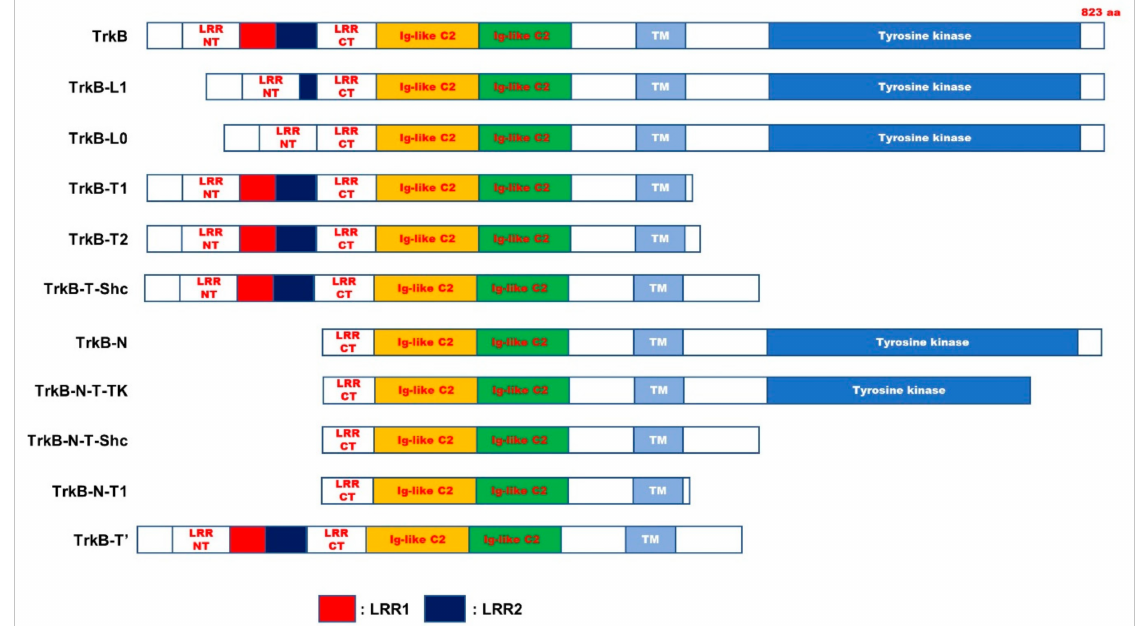
Figure 4. Schematic representation of TrkB full length and truncated isoforms. The domain of TrkB exhibited as filled boxes. TrkB-N, TrkB-N-T-TK, TrkB-N-T-Shc, and TrkB-N-T1 have a lack of N-terminal signal sequence, leucine-rich repeat N-terminal domain (LRRNT), leucine-rich repeat region 1 (LRR1), and LRR2 domain of TrkB. Also, TrkB-L1 and TrkB-L0 lacked the first two or three or all three of LRRs in the extracellular domain of TrkB, respectively. Additionally, TrkB.T1 and TrkB.T2, TrkB-T-Shc,